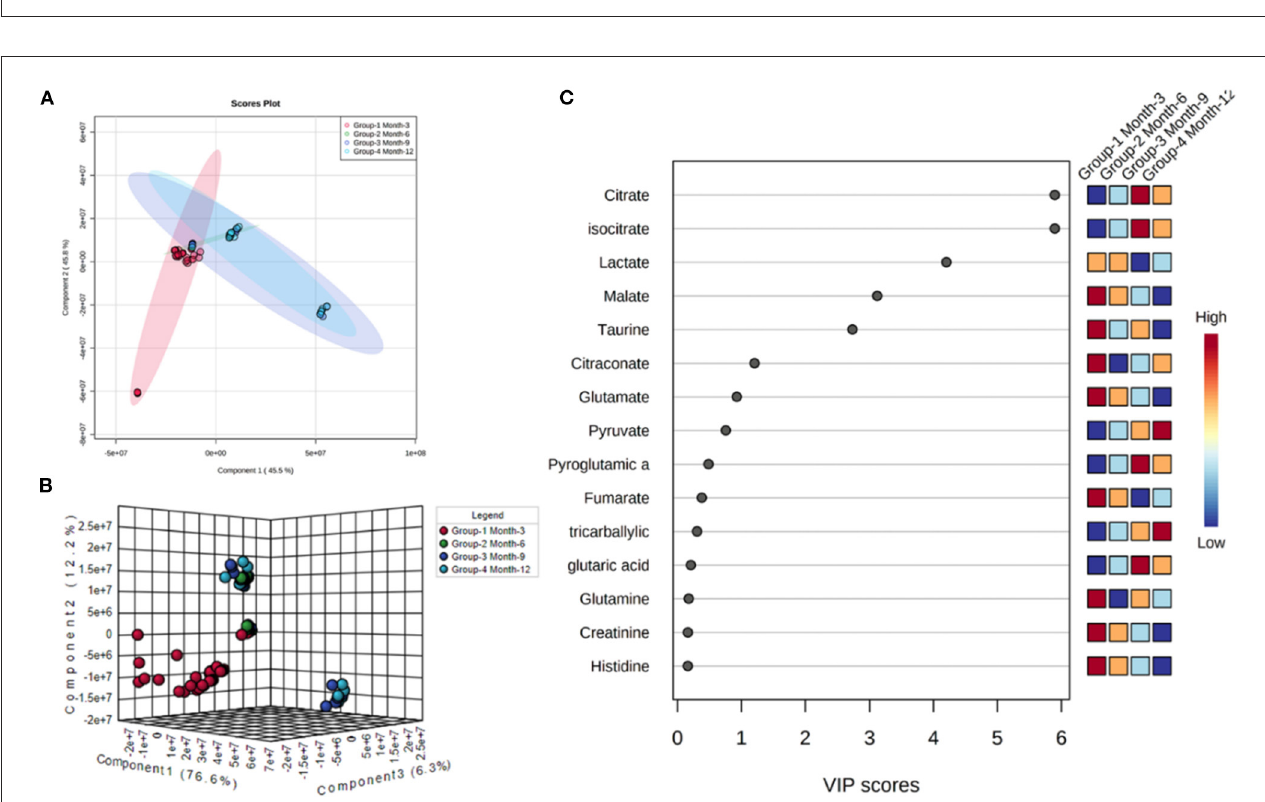
FIGURE7 2D (A) and 3D PLS-DA (B) plots showing separation of small molecule profiles for samples with groups color coded to designate 3, 6, 9, and 12-month groups. VIP score chart (C) illustrating metabolites driving group separation across study period.